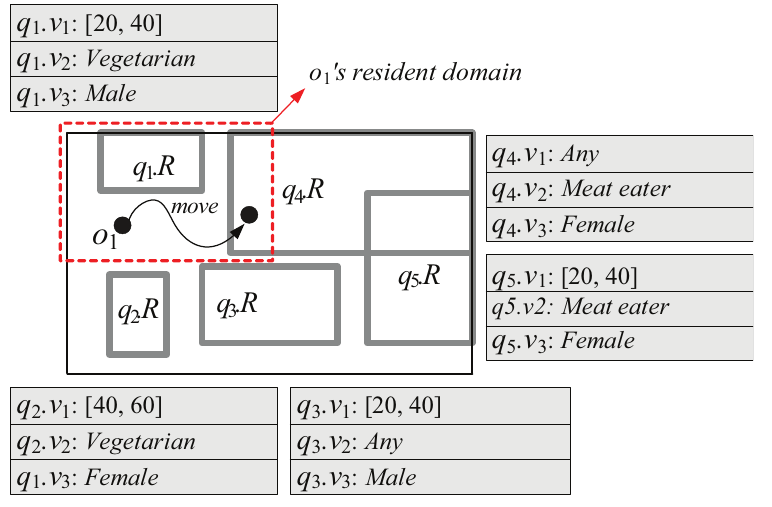
Figure 3. Example of content-matched (CM) range monitoring